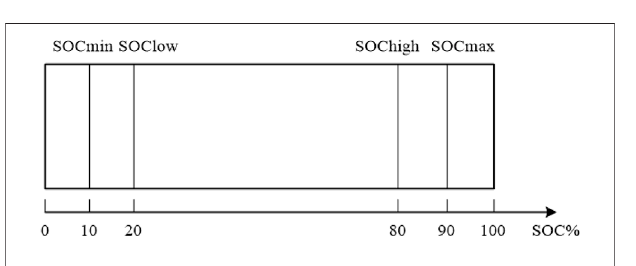
FIGURE 2 | State of charge (SOC) interval model.